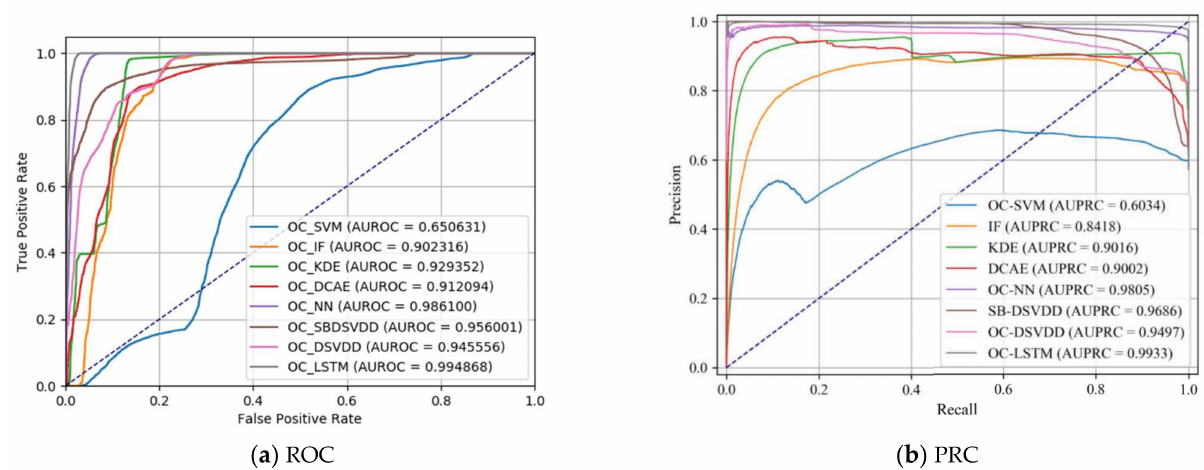
Figure 5. The ROC and PRC for each model on the CIC-DDoS dataset.